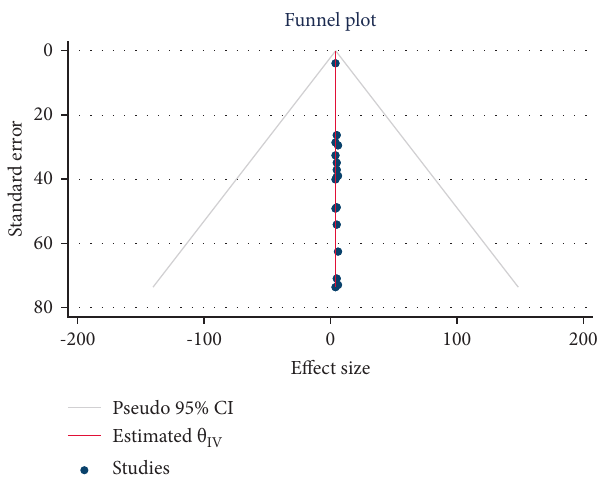
Figure 15: Meta funnel plot presentation, an indication of pub- lication bias among studies in Ethiopia from 2005 to